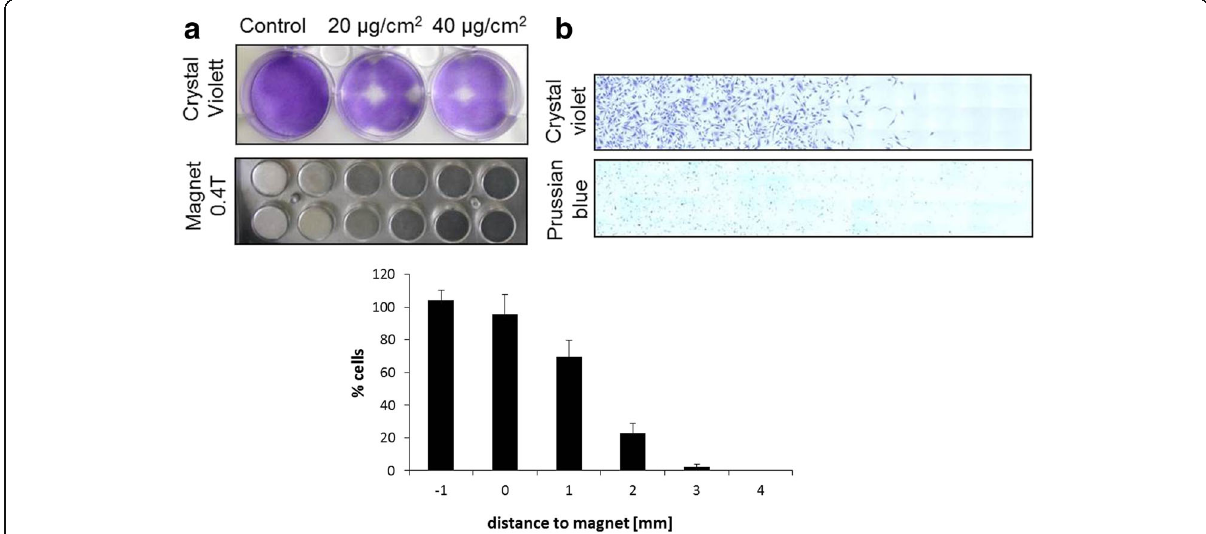
Fig. 5 2D magnetic guidance of VFF. a Magnetic guidance of SPION-loaded VFF shows cells only growing in areas where the magnet is present. Upper : VFF loaded with 0 (control), 20, or 40 μ g/cm 2 SPIONs seeded in a 6-well plate, which was placed on top of a 24-well magnet plate ( lower ). ( b ) Crystal violet ( upper ) and Prussian blue ( lower ) staining of VFF grown over the magnet ( left ) and in magnet-free zone ( right ). Quantitative analysis: % of cells measured in 4 mm distance of the